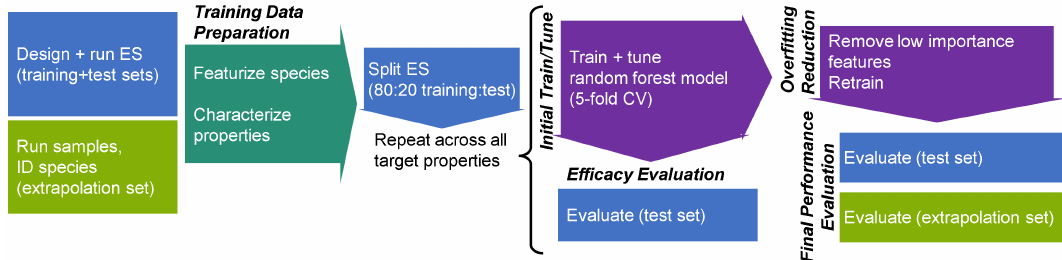
Figure 1. Analytical pipeline for chemical properties modeling using a random forest model. ES indicates the external standard; CV indicates the